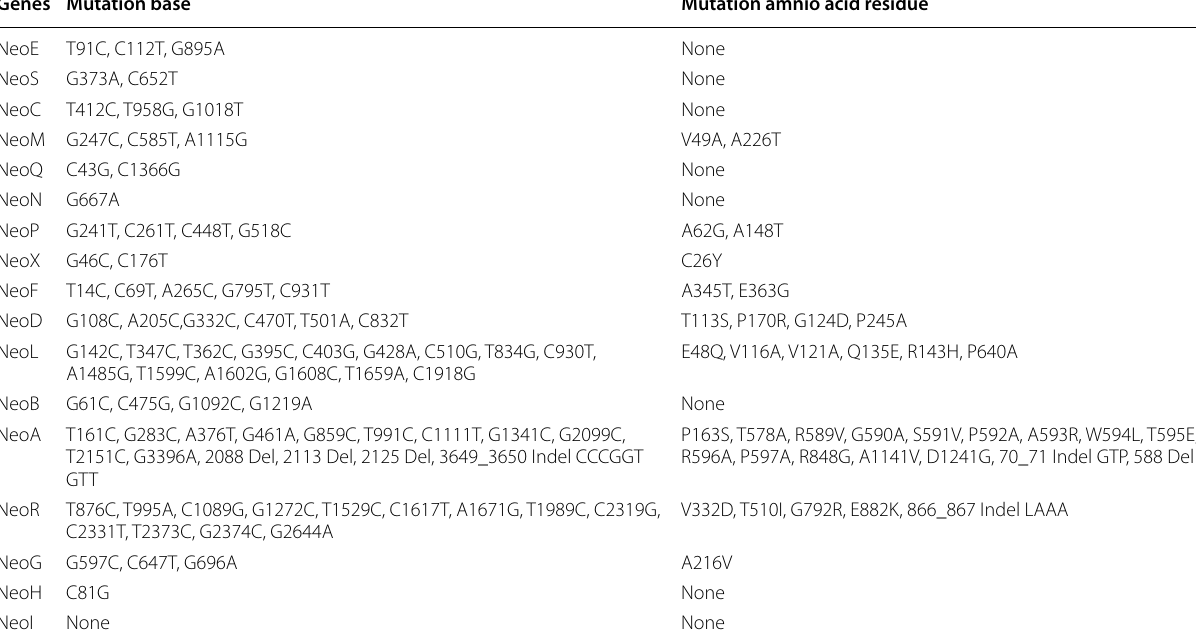
Table 2 Whole-genome sequencing of strain SF-2 with respect to neomycin biosynthesis pathway Genes Mutation base